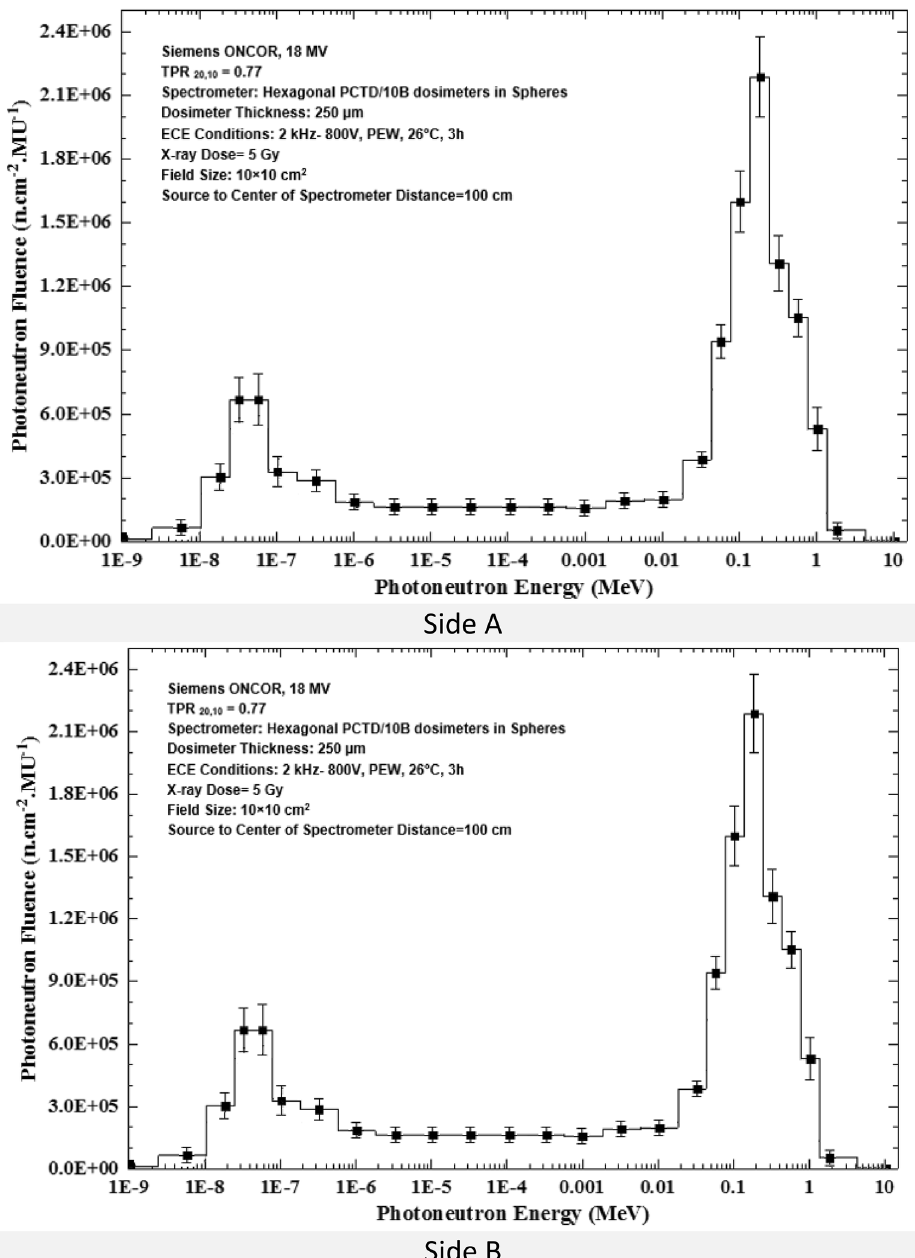
Figure 5. ( a–f ) PN spectra determined by the 6 PCTD/ 10 B detectors fixed on 6 sides A, B, C, D, E, and F of PE cubes (one bare and 8 embedded in 8 PE spheres) exposed to PNs at the isocenter to 5 Gy 18 MV X-ray dose in the 10 × 10 cm 2